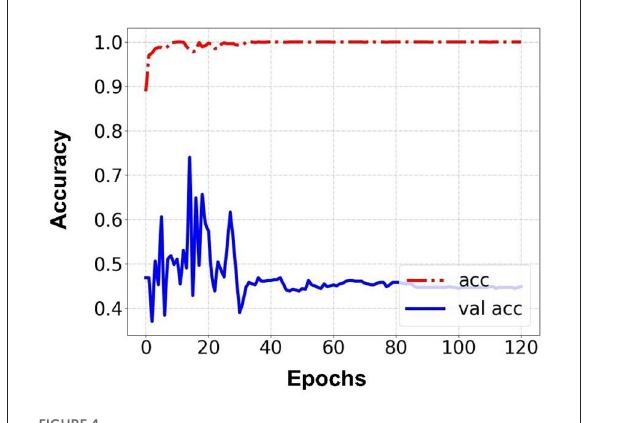
FIGURE6 AUC for Task 2 in an image.